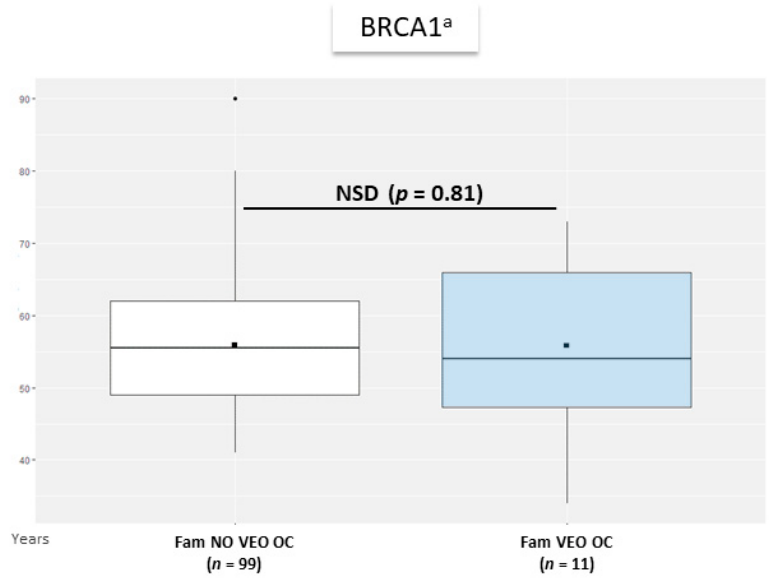
Figure 3. Average of mean age at OC diagnosis of female relatives of women with VEO-OC versus no VEO-OC among BRCA1m carrier women. Fam. VEO-OC: families with at least one or more VEO-OC case. Fam. NO VEO-OC: families without VEO-OC cases. ( n ): number of families with available data for age at first OC diagnosis in women. a : among BRCA1m carrier women. Horizontal line is median, box edges are 1st and 3rd quartile and whiskers are range of age at diagnosis of BC in relatives in each family. Central black square is the mean average age at diagnosis of BC in relatives in each family.